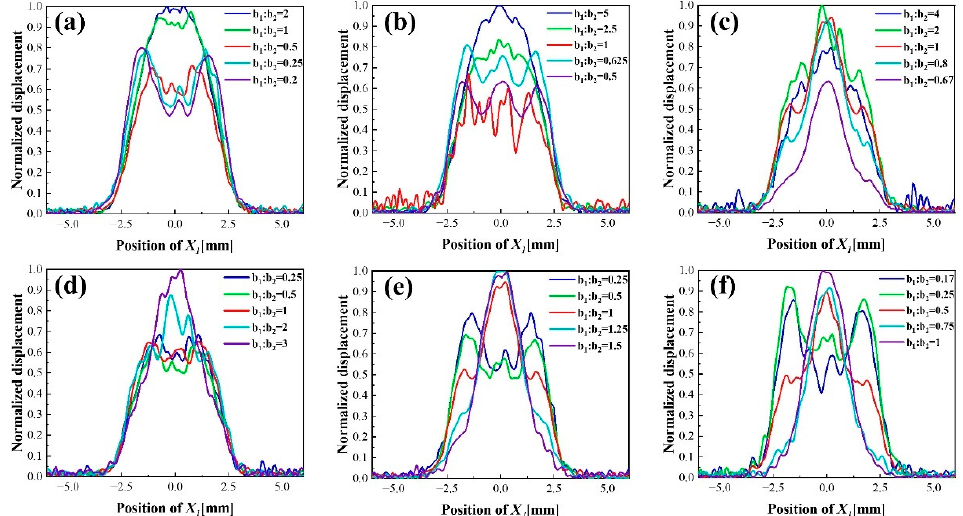
Figure 5. Normalized displacement distribution in X 1 direction on electric shaft X 1 of the dot-finger electrode: ( a – c ) Fixed dot electrode radius b 1 is 0.2 mm, 0.5 mm, 0.8 mm with different ratio of b 1 to b 2 ; ( d – f ) Fixed gap width b 2 is 0.4 mm, 0.8 mm, 1.2 mm with different ratio of b 1 to b 2 .